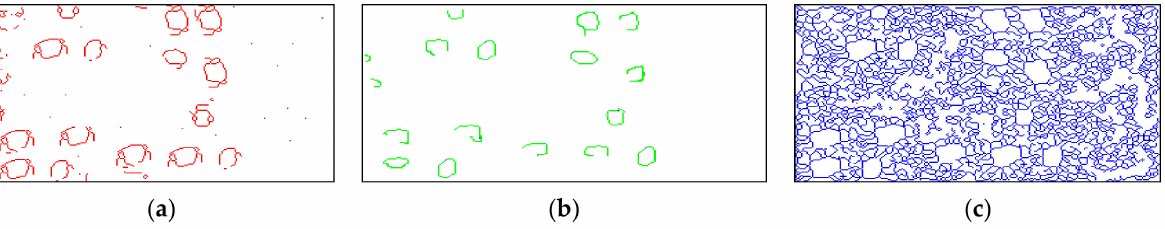
Figure 3. The result of separating informative segments of the steel ladle thermogram from the background: ( a ) Sobel/Prewitt filters; ( b ) Roberts filter; ( c ) Canny